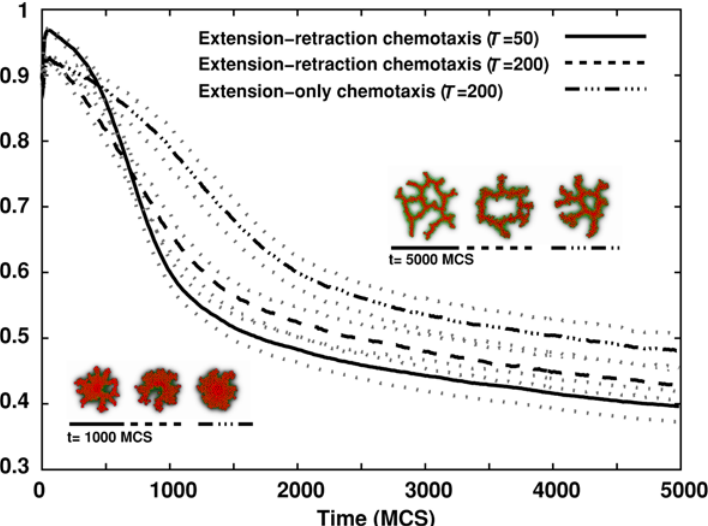
Figure 12. Evolution of the compactness ( C = A cluster / A hull ) of 256-cell clusters on 500 6 500-pixel lattices ( , 1,000 m m 6 1,000 m m) vs. time for standard Savill-Hogeweg [ 36 ] extension-retraction chemotaxis (solid and dashed curves, for T =50 and T =200 respectively), and for extension-only chemotaxis (dash-dotted curve, T = 200), with only extending pseudopods responding to the chemoattractant. Black curves show the mean of 100 simulations. Dotted grey curves mark one standard deviation. Insets: Representative configurations after 1000 ( , 8 h) and 5000 MCS ( , 40 h). Videos available online.